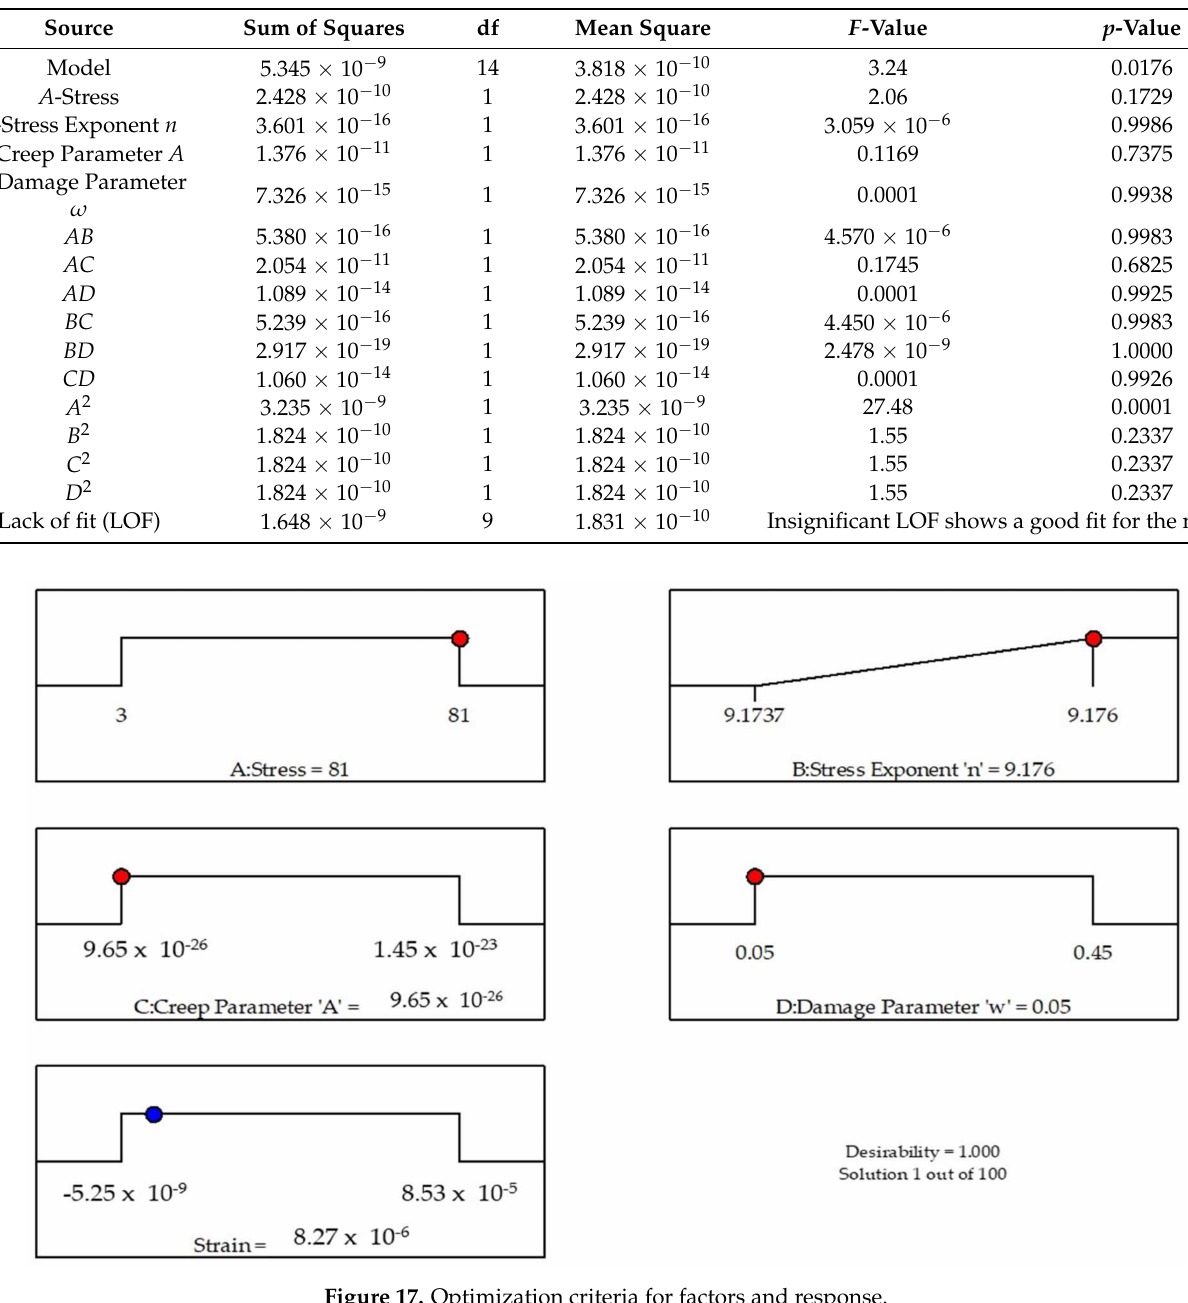
Figure 17. Optimization criteria for factors and